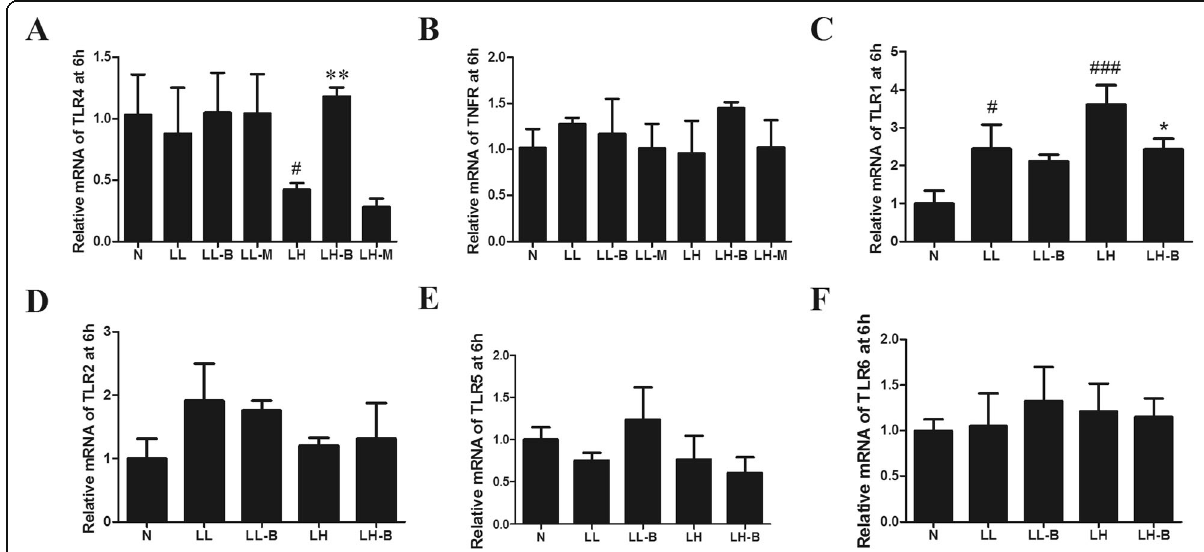
Fig. 8 Effects of BBR on mRNA levels of inflammation-related proteins induced by LPS in Raw264.7 cells. ( a ) TLR4. ( b ) TNFR. ( c ) TLR1. ( d ) TLR2. ( e ) TLR5. ( f ) TLR6. N, normal control group; LL, low LPS group; LL-B, low LPS+BBR group; LL-M, low LPS+Metformin group; LH, high LPS group; LH-B, high LPS+BBR group; LH-M,high LPS+Metformin group; compared with N group, # P <0.05, ### P <0.001; compared with LL or LH group, * P <0.05, *** P